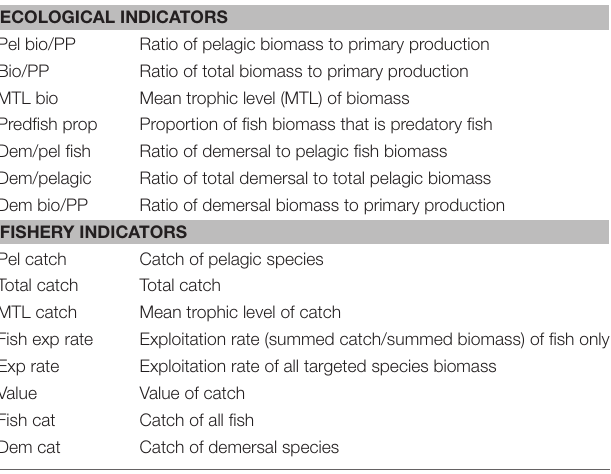
TABLE 2 | Ecological and fishery